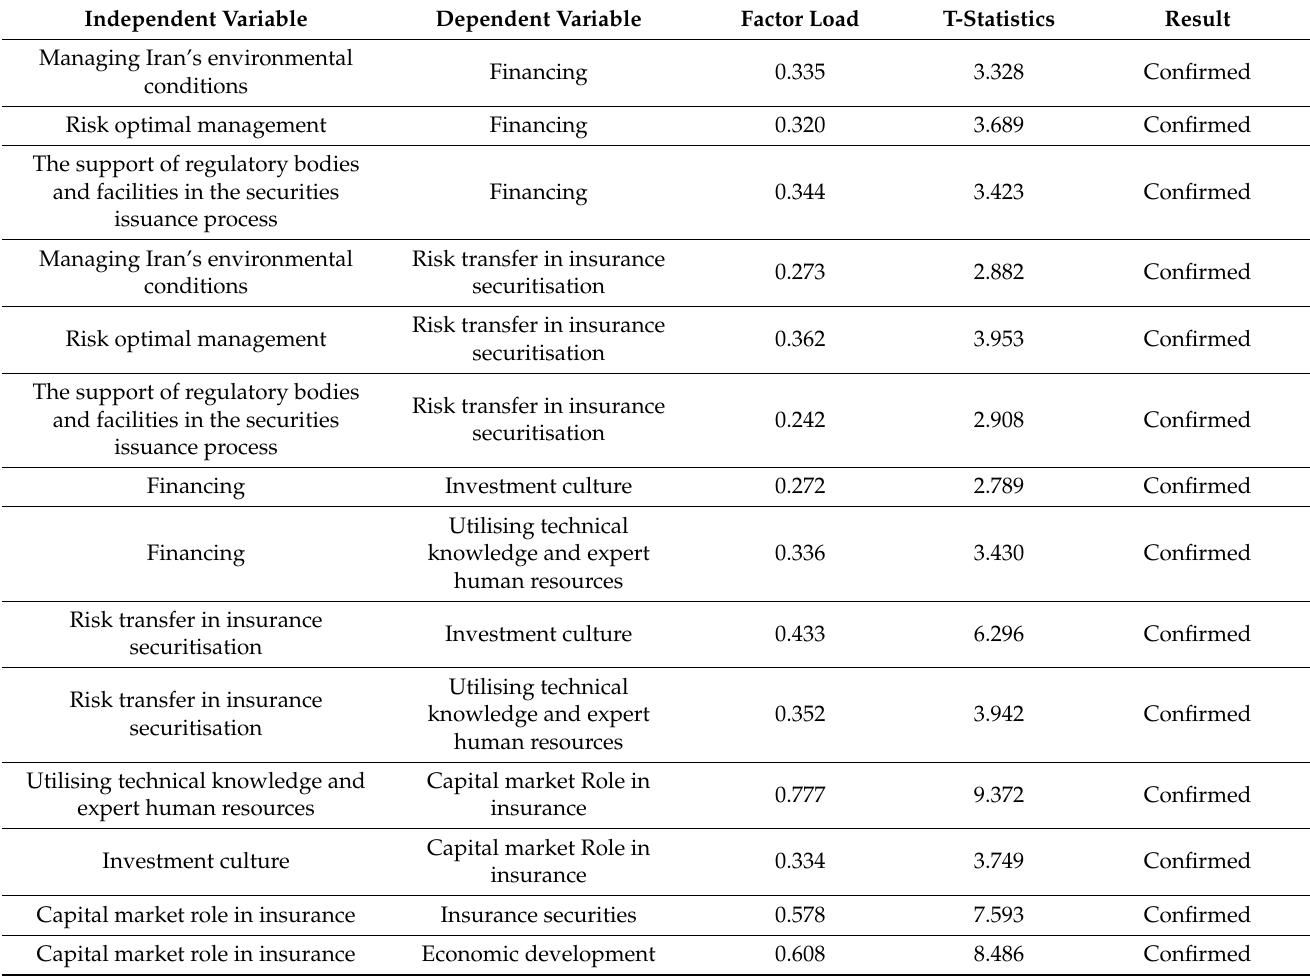
Table 2. The Summary of the test results of the research hypotheses.